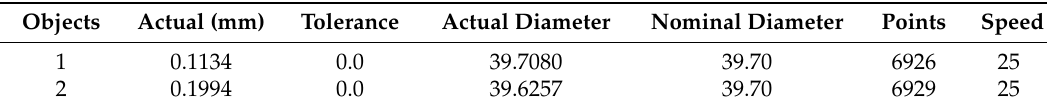
Table 3. Roundness measurement of different balls by CMM.